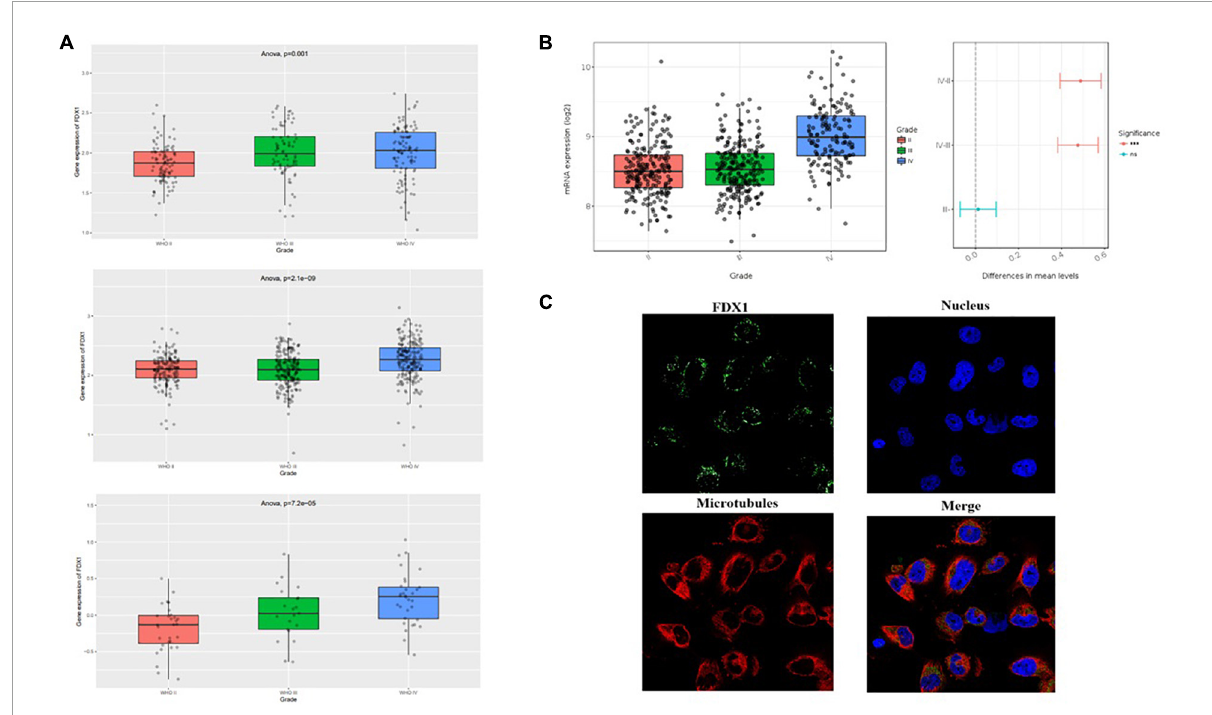
FIGURE2 Expression level analysis of Fdx1 gene in multiple public databases. (A) Expression of Fdx1 gene in three independent research cohorts of CGGA. (B) Expression of Fdx1 gene in TCGA dataset (LGG-GBM). (C) Expression of FDX1 in glioma cell line U251 cells (the data from Human Protein Altas public